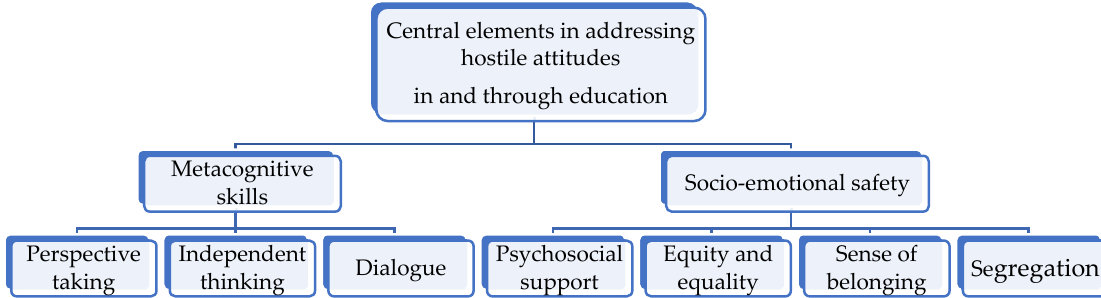
Figure 1. Central elements in addressing hostile attitudes in and through education.